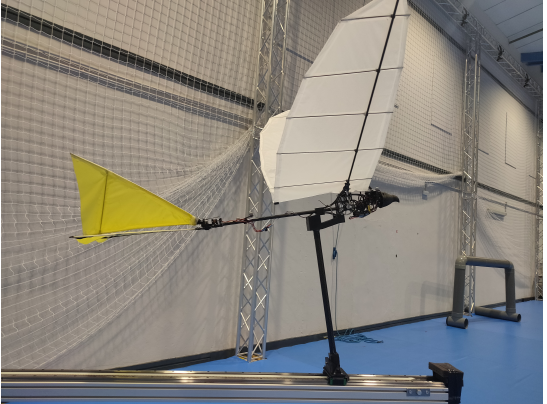
Figure 4. Ornithopter prototype used in the